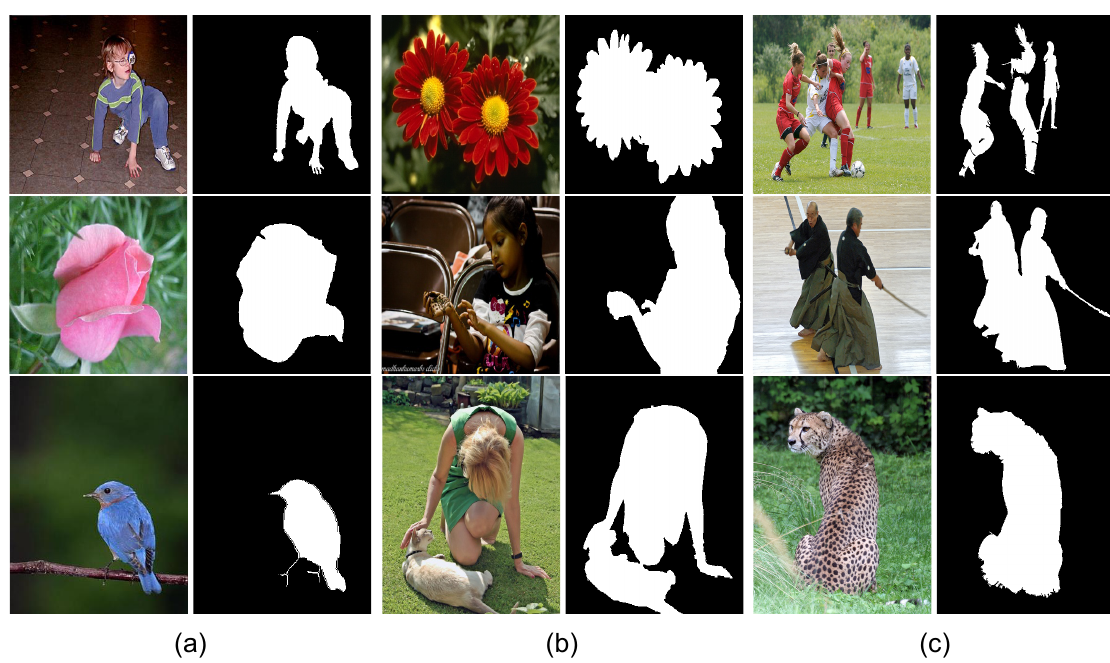
Figure 4. Three sample images of each dataset used and their corresponding ground truth: ( a ) MSRA1K dataset; ( b ) ECSSD dataset; and ( c ) iCoseg